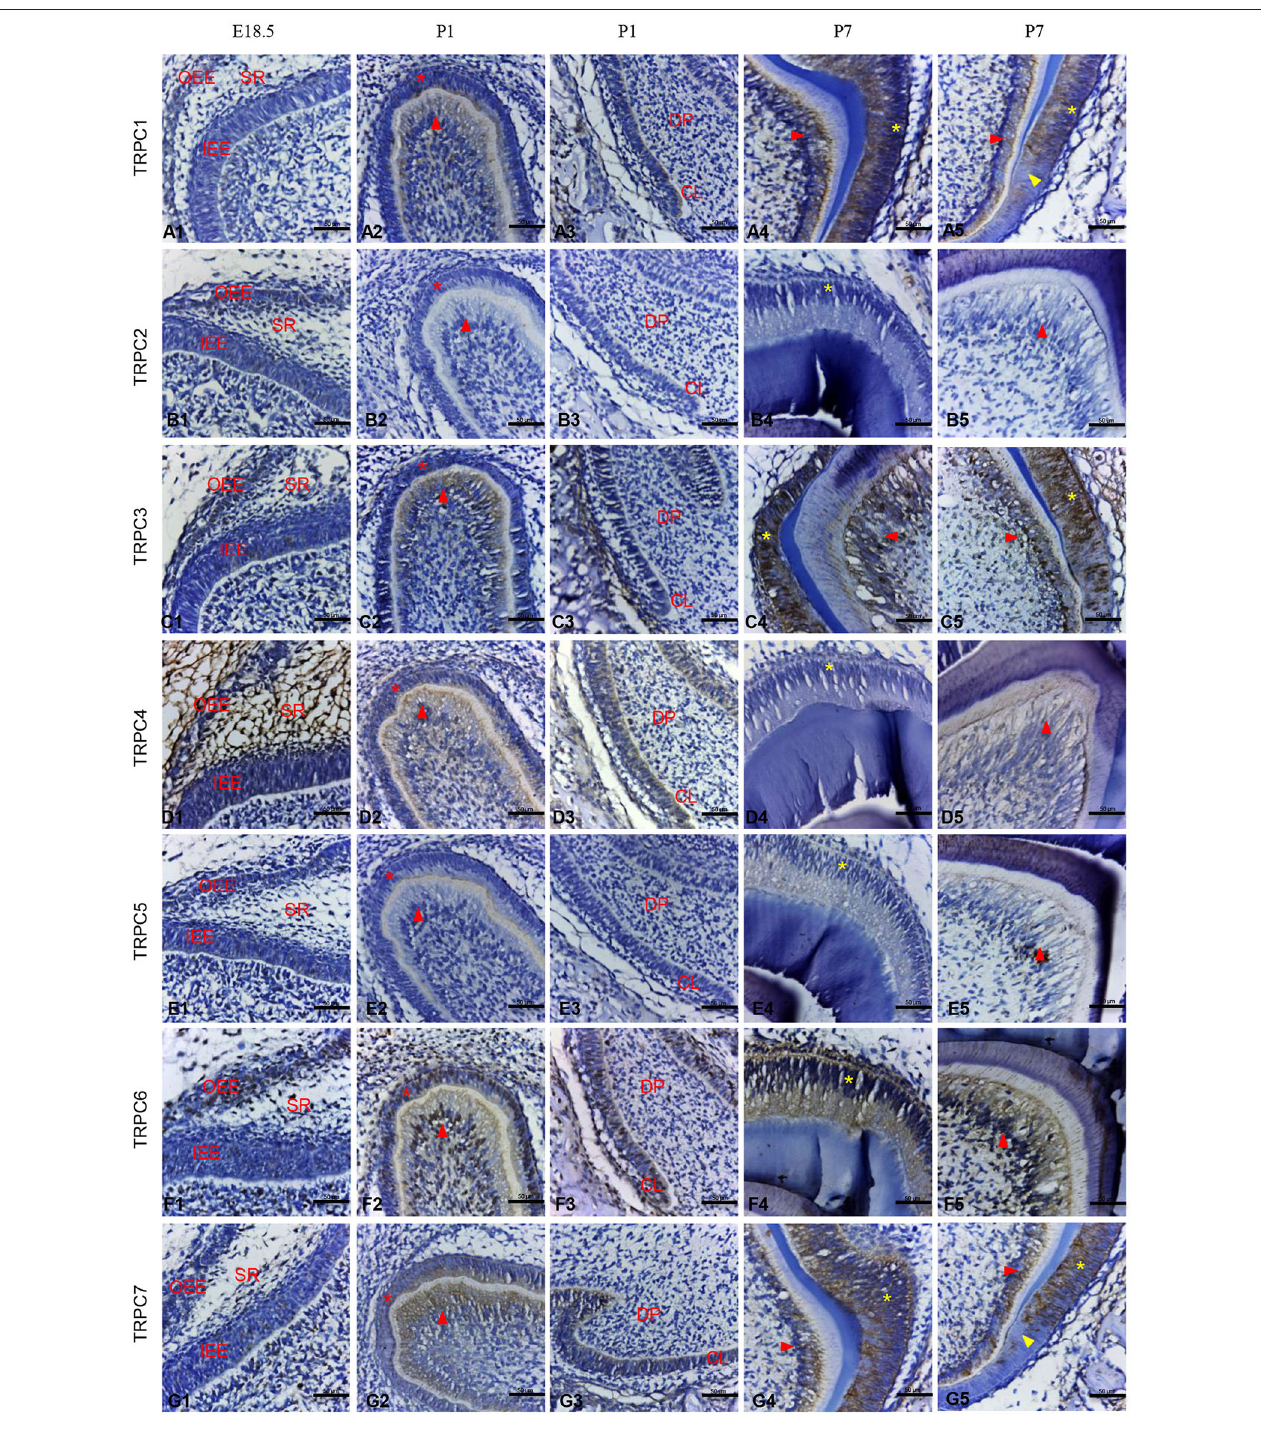
FIGURE 5 | IHC staining of TRPC channels in the rat tooth germ development at E18.5, P1, and P7 stages in higher magnification. At E18.5, weak expression of TRPC3, TRPC6, TRPC7 were found in inner and outer enamel epithelial cells (C1, F1, G1) . The expression of TRPC4 was observed in stellate reticulum cells and dental follicle cells (D1) . At P1, the expression of TRPC1, TRPC3, TRPC4, TRPC6 and TRPC7 were detected in preameloblasts (* in A2, C2, D2, F2, G2 ), odontoblasts (red arrowhead in A2, C2, D2, F2, G2 ) and cervical loop (A3, C3, D3, F3, G3) . At P7, the expression of TRPC1, TRPC3, TRPC6 and TRPC7 were detected in ameloblasts (* in A4, A5, C4, C5, F4, G4, G5 ) and odontoblasts (red arrowhead in A4, A5, C4, C5, F5, G4, G5 ). TRPC1 and TRPC7 were strongly expressed in ameloblasts adjacent to mineralized tissue (yellow arrowhead in A5, G5 ). TRPC2 and TRPC5 were not detected at E18.5, P1 and P7 (B1–B5, E1–E5) . Scale bars: 50 µ m. OEE, outer enamel epithelium; IEE, inner enamel epithelium; CL, cervical loop.